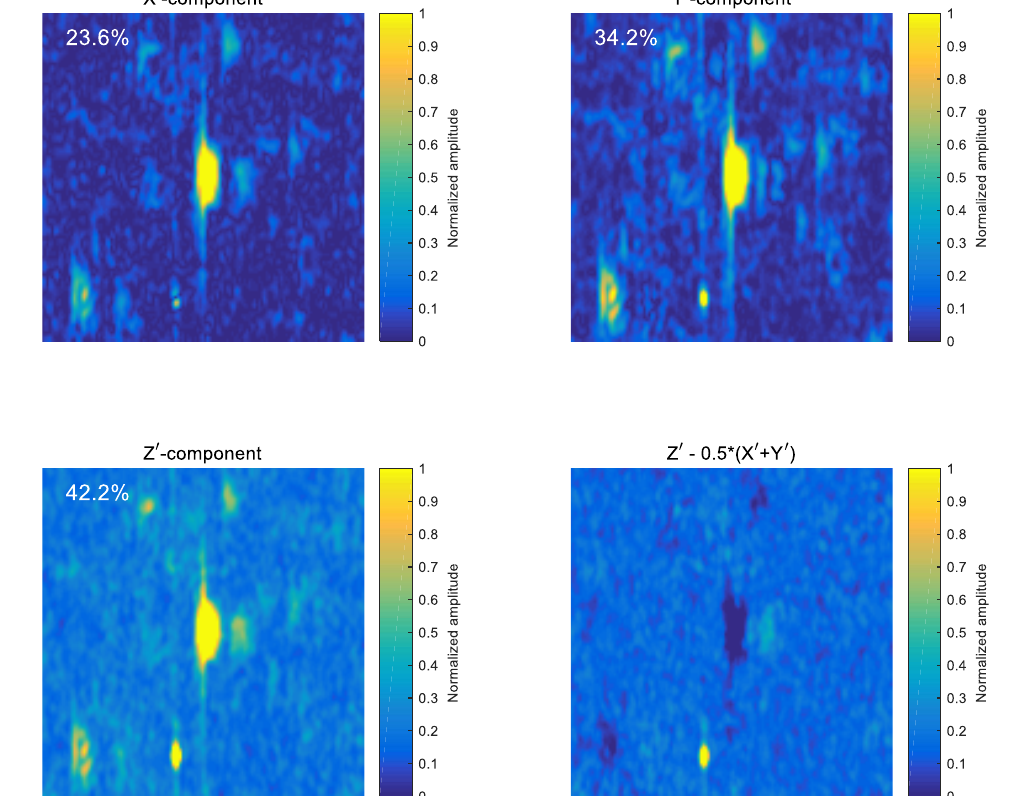
Figure 7. Projection of multi-look components of ghosts to new axes (X′, Y′, Z′) by the rotation matrix. Compared with the original (X, Y, Z) components in Figure 5, signal powers of ghosts are now evenly distributed among the X′-axis ( upper left ), Y′-axis ( upper right ), and Z′-component ( bottom left ) with portions of the total signal power of 23.6%, 34.2%, and 42.2%, respectively. Compared with the original image shown in Figure 3b, ghosts in the final output obtained by the proposed method are effectively suppressed ( bottom right ).